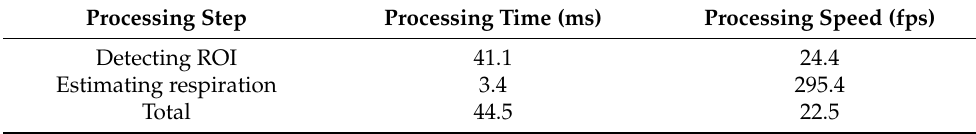
Table 2. Performance results for the overall data and each of the three